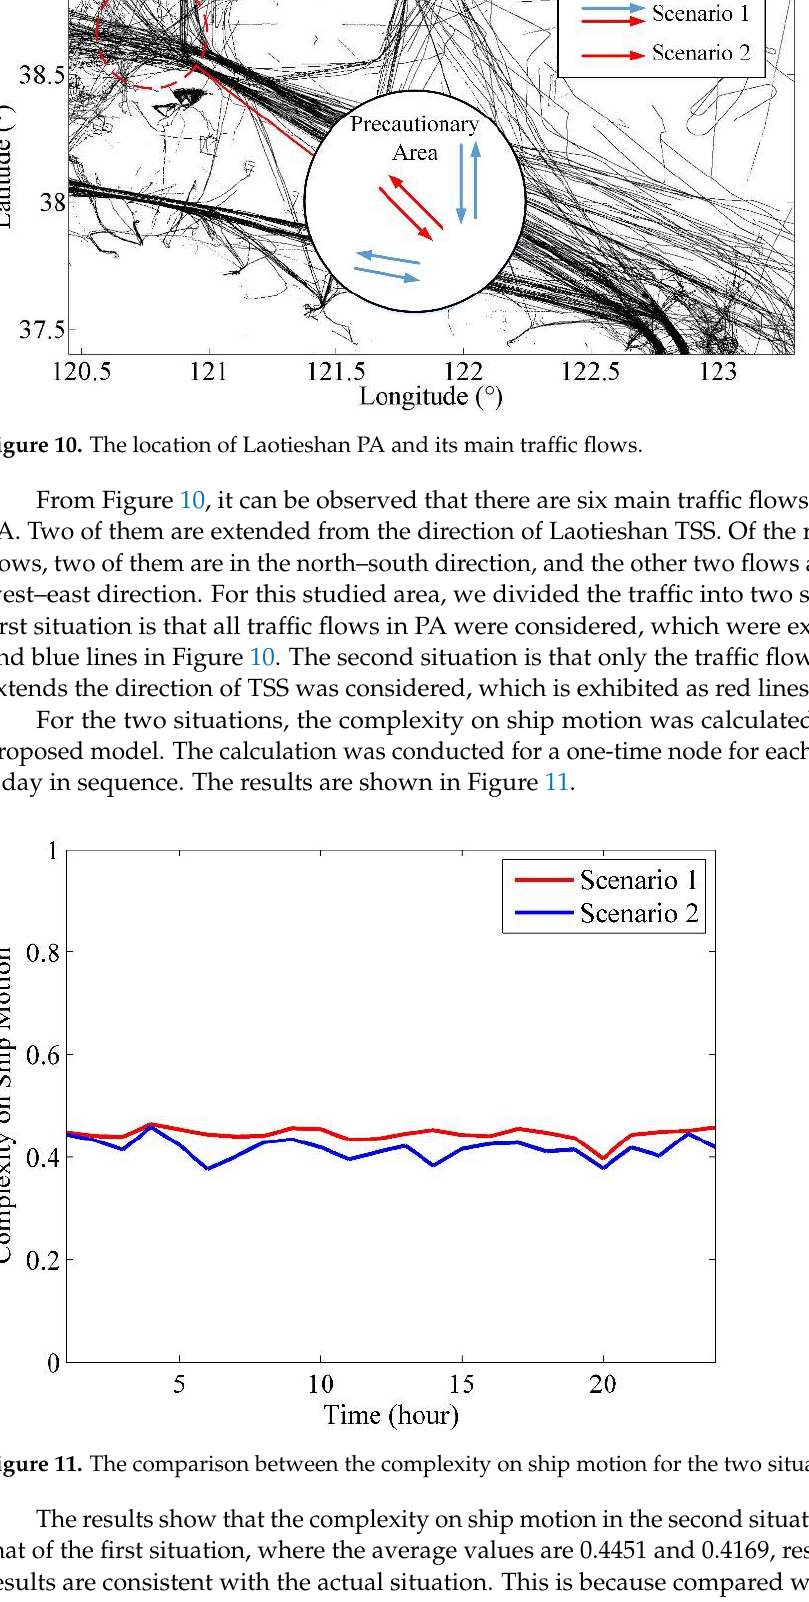
Figure 11. The comparison between the complexity on ship motion for the two situations . The results show that the complexity on ship motion in the second situation is less than that of the first situation, where the average values are 0.4451 and 0.4169, respectively. The results are consistent with the actual situation. This is because compared with the second situation, there are more different traffic flows considering in the first situation, which makes the speed and course more varied and leads to the increase of complexity